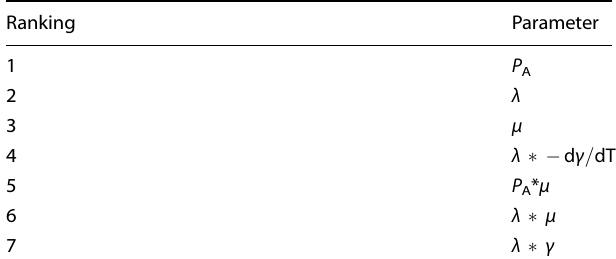
Table 6. Parameter ranking of main effects and 2-factor interactions of the LASSO model.